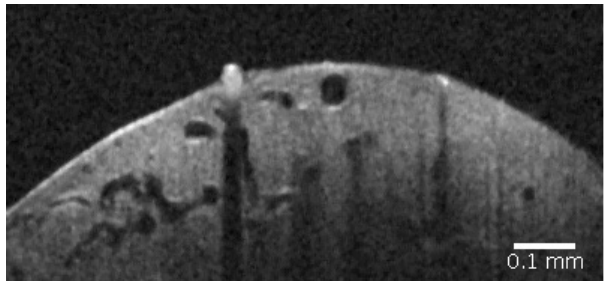
Fig. 8. OCT image of deep lymphatic node.